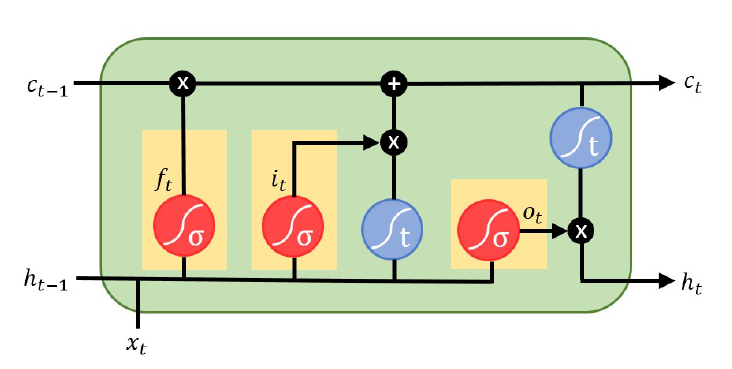
Figure 5. Structure of the LSTM